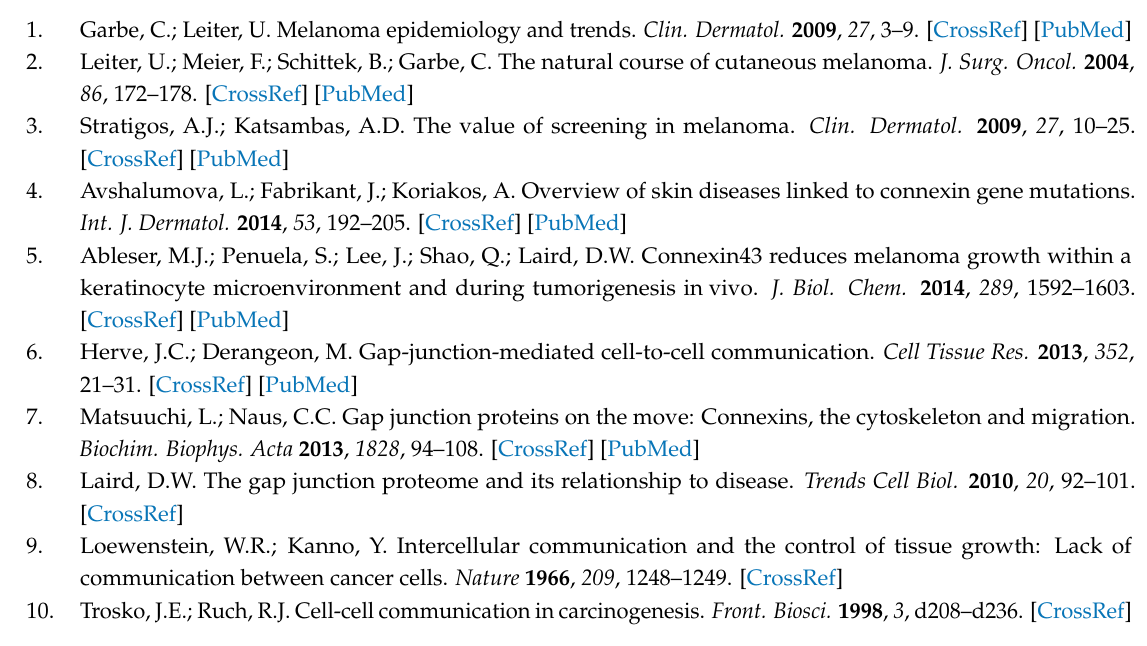
Table S1: Antibodies tested in human skin tissues but were not found to be specific or reliable in this